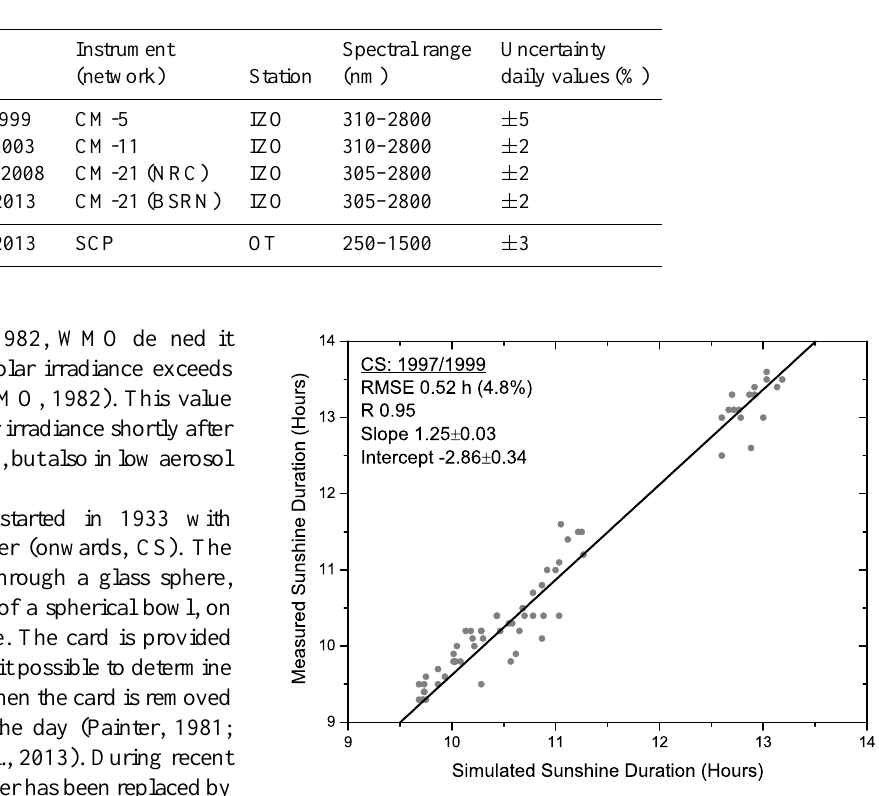
Table 1. Pyranometers installed between 1992 and 2013 at IZO and OT.